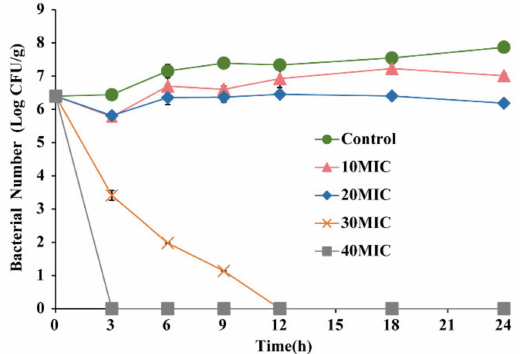
Figure 13. Antimicrobial activity of OEO on E. faecalis ATCC 29212 in raw chicken.